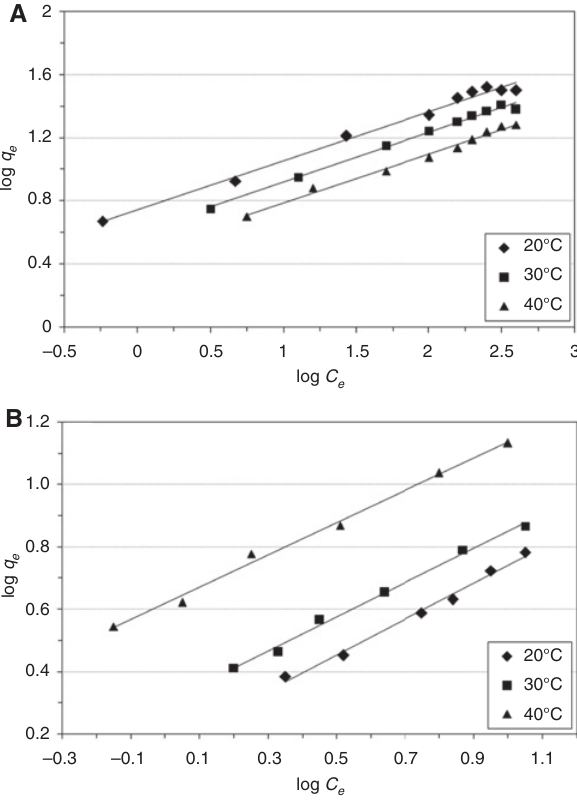
Figure 9: Freundlich isotherm plots for Mn-doped laterite: (A) phos- phate, (B)